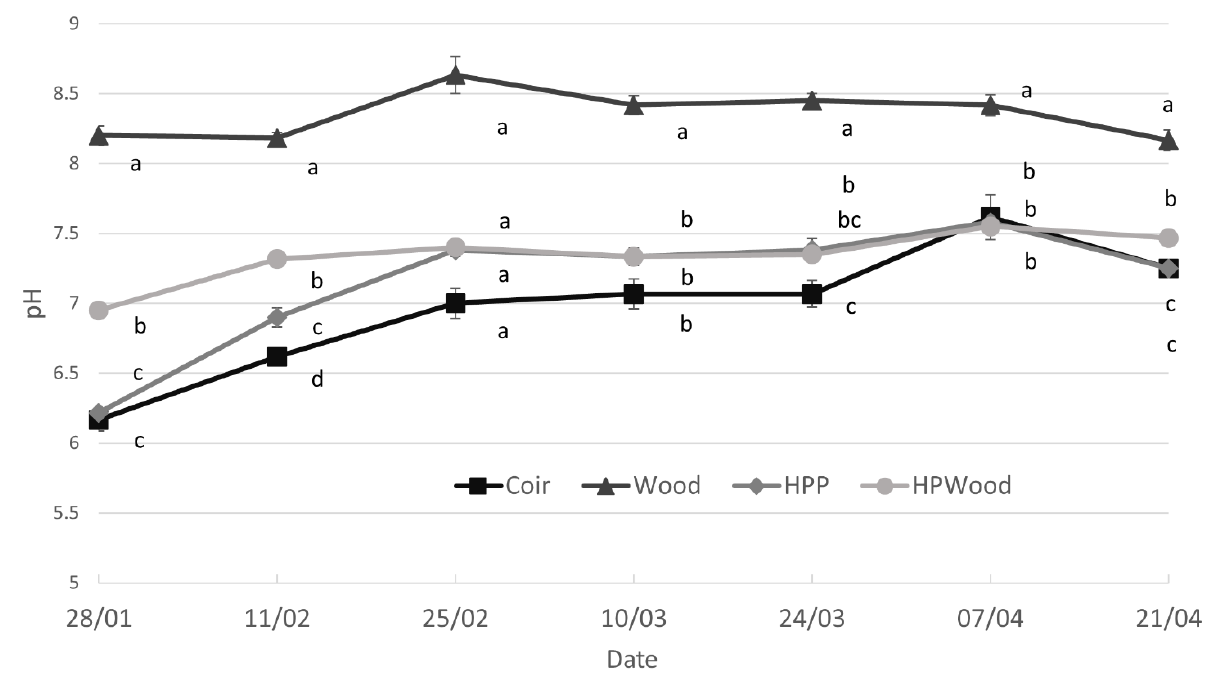
Figure 3. Time series of pH in drainage water collected from the Bottom level of arctic bramble plant towers with different substrates. Vertical bars represent ± SE (n = 6). Different lowercase letters indicate statistically significant differences between the substrates at each date (P <0.05) by Tukey’s